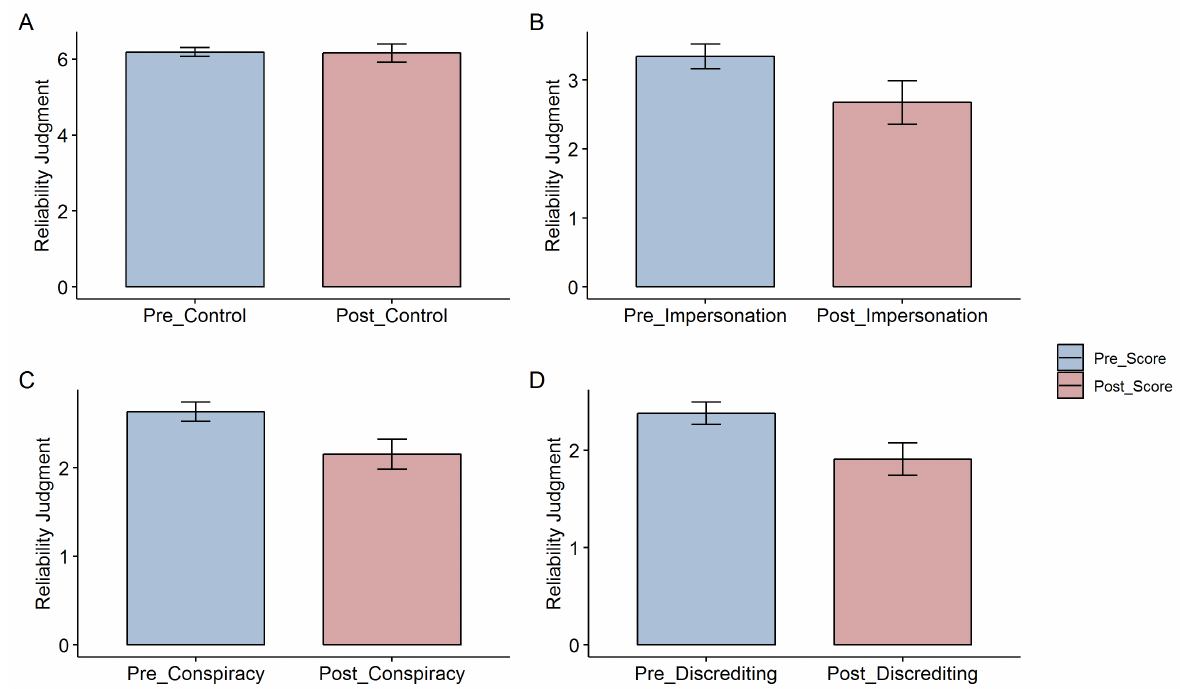
Figure 2. Perceived reliability judgments for “real” control items (averaged, panel A), impersonation (panel B), conspiracy (panel C), and discrediting (Panel D), for the Swedish version of the game. The error bars represent 95% confidence intervals. The figure shows that the credible news items were perceived as equally reliable before and after playing, whereas the “fake” items are seen as significantly less reliable. All mean pre and post scores can be found in Table 3 in the